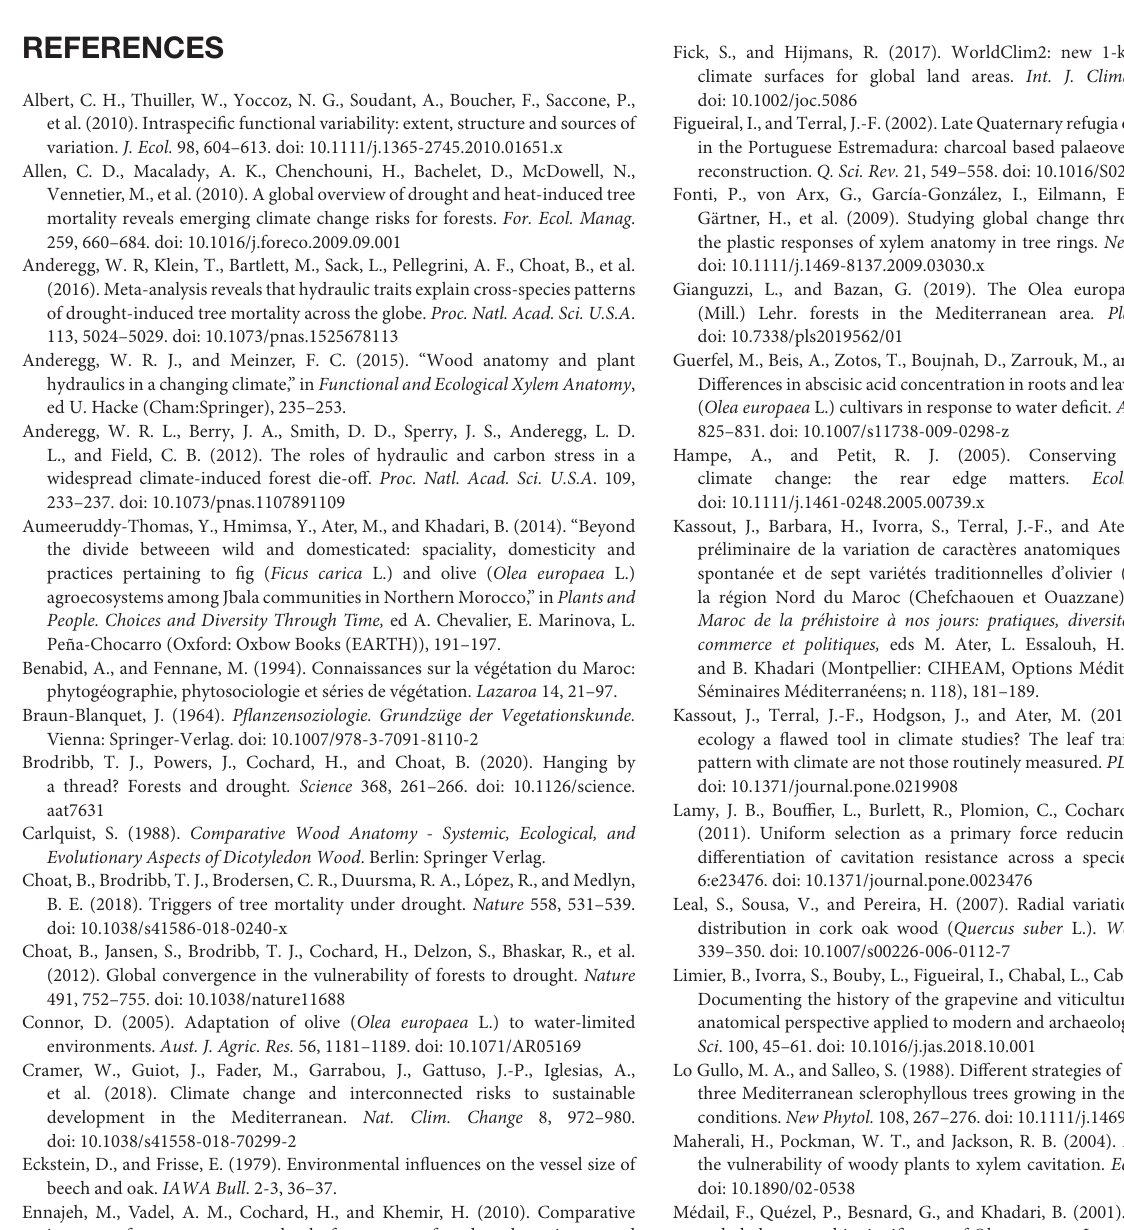
Supplementary Table 4 | Results of mean comparison tests ( t- test for data sets following a normal distribution, Mann-Whitney in the contrary case) of two sessions carried out by the same operators. Supplementary Table 5 | Eco-anatomical data and diameter (mean values) of wood samples for each population alphabetically listed. Supplementary Table 6 | Variance decomposition of vessel surface area (SVS) across the studied levels.